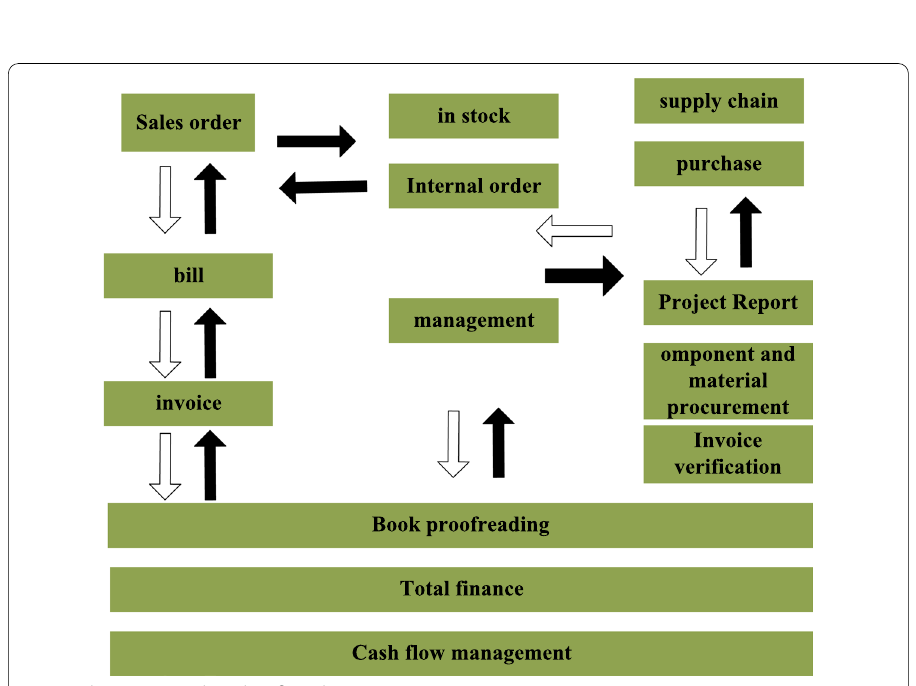
Fig. 7 The corresponding data flow